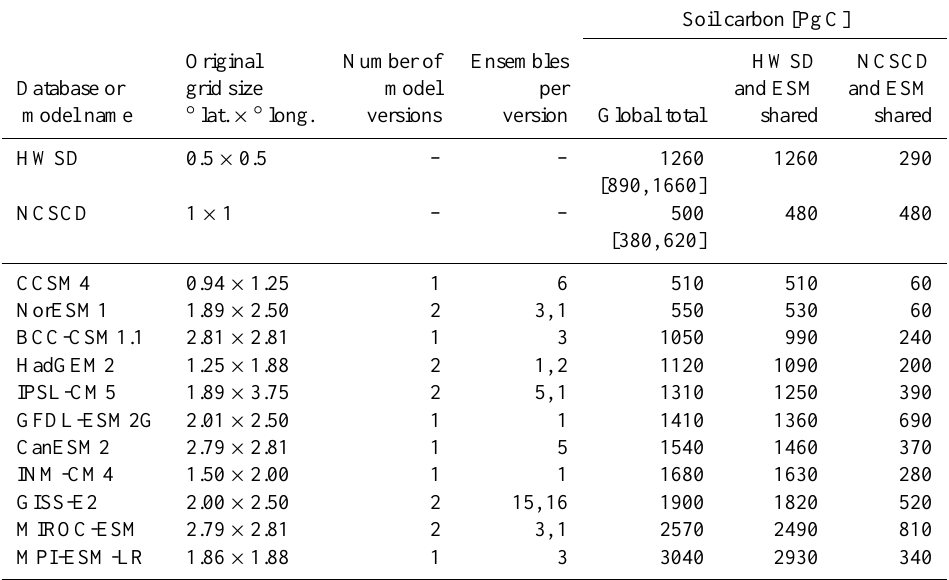
Table 2. Soil carbon totals across all grid cells in each ESM, grid cells present in the HWSD and ESM, and grid cells present in the NCSCD and ESM. Database totals include 95% confidence intervals based on qualitative uncertainty analysis, shown in brackets. Values are rounded to the nearest